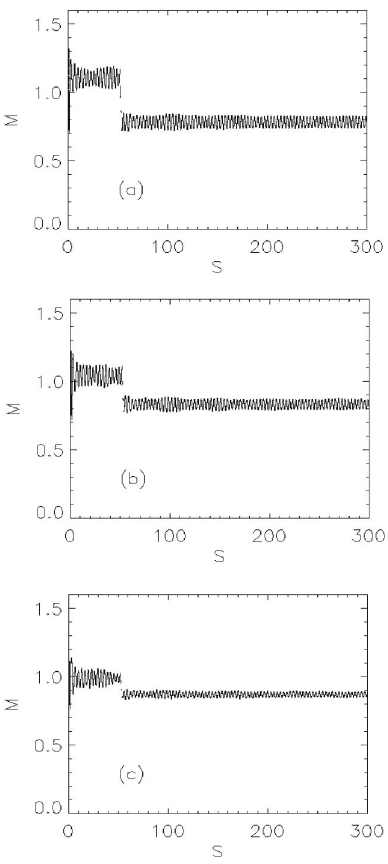
FIG. 12. Phase space distribution at the end of of oscillations shown in Fig. 11 at the last maximum rms width when S (cid:10) 300 for (cid:4) (cid:1) (cid:4) a (cid:5) 1.5, (b) 1.35, (c) 1.2.